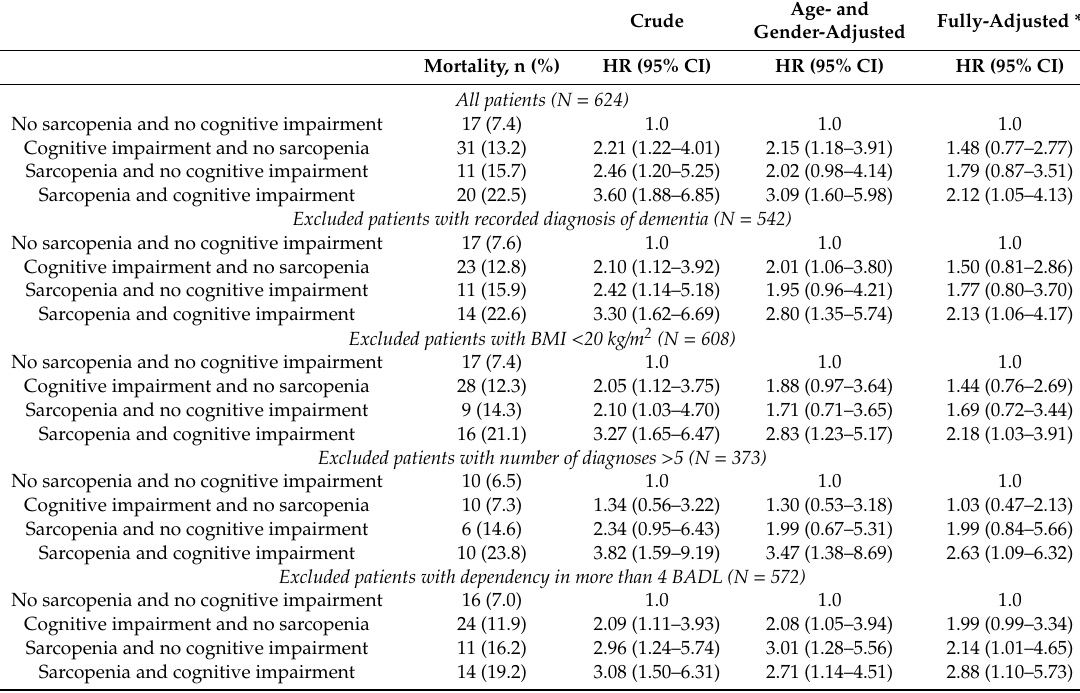
Table 2. Cox regression analysis of cognitive impairment only, sarcopenia only, or sarcopenia and cognitive impairment to 1-year mortality.